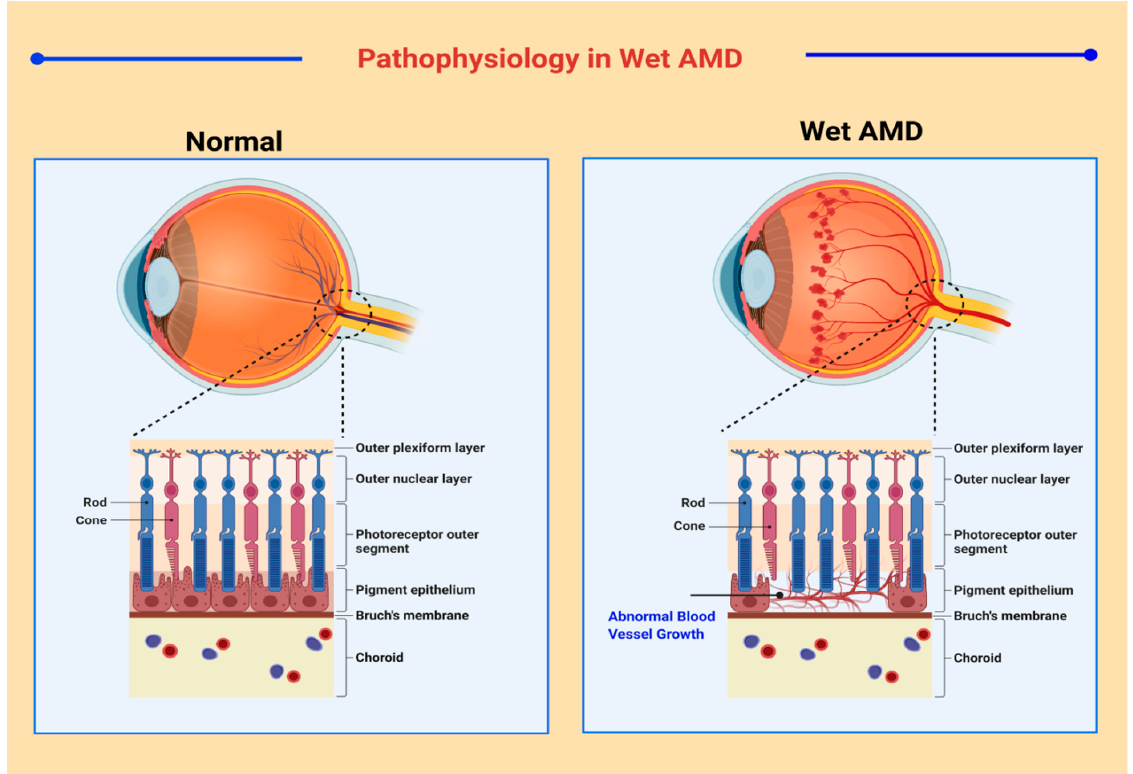
Figure 1. Anatomical and Pathophysiological features of retina cell layers in neovascular AMD . Normal Vision and wet AMD.